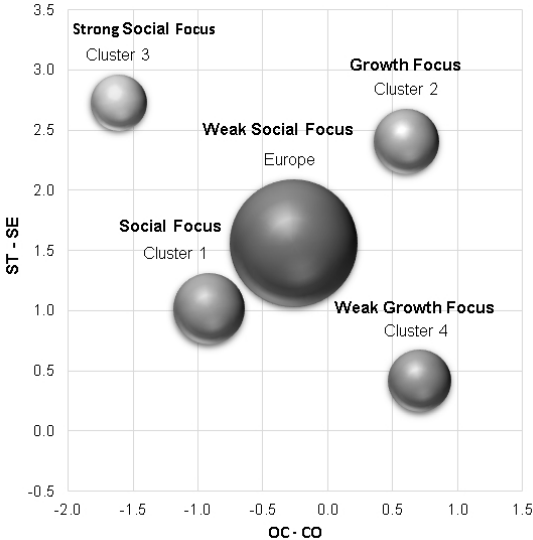
Figure 3. Comparison of Europe with the four clusters in the two-dimensional Schwartz value space. The area of the spheres is proportional to the cluster percent size (Europe being 100%). ST—stimulation; SE—security; CO—conformity.